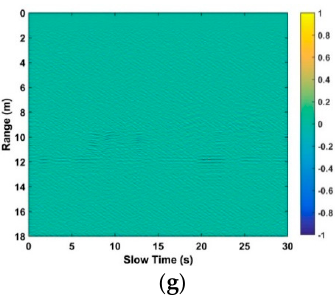
Figure 9. The resultant matrix from the ( a ) radar receiver; ( b ) static background suppression; ( c ) automatic gain control (AGC); ( d ) band pass filter; ( e ) AGC; ( f ) averaging filter in distance direction; and ( g ) averaging filter in slow time direction.